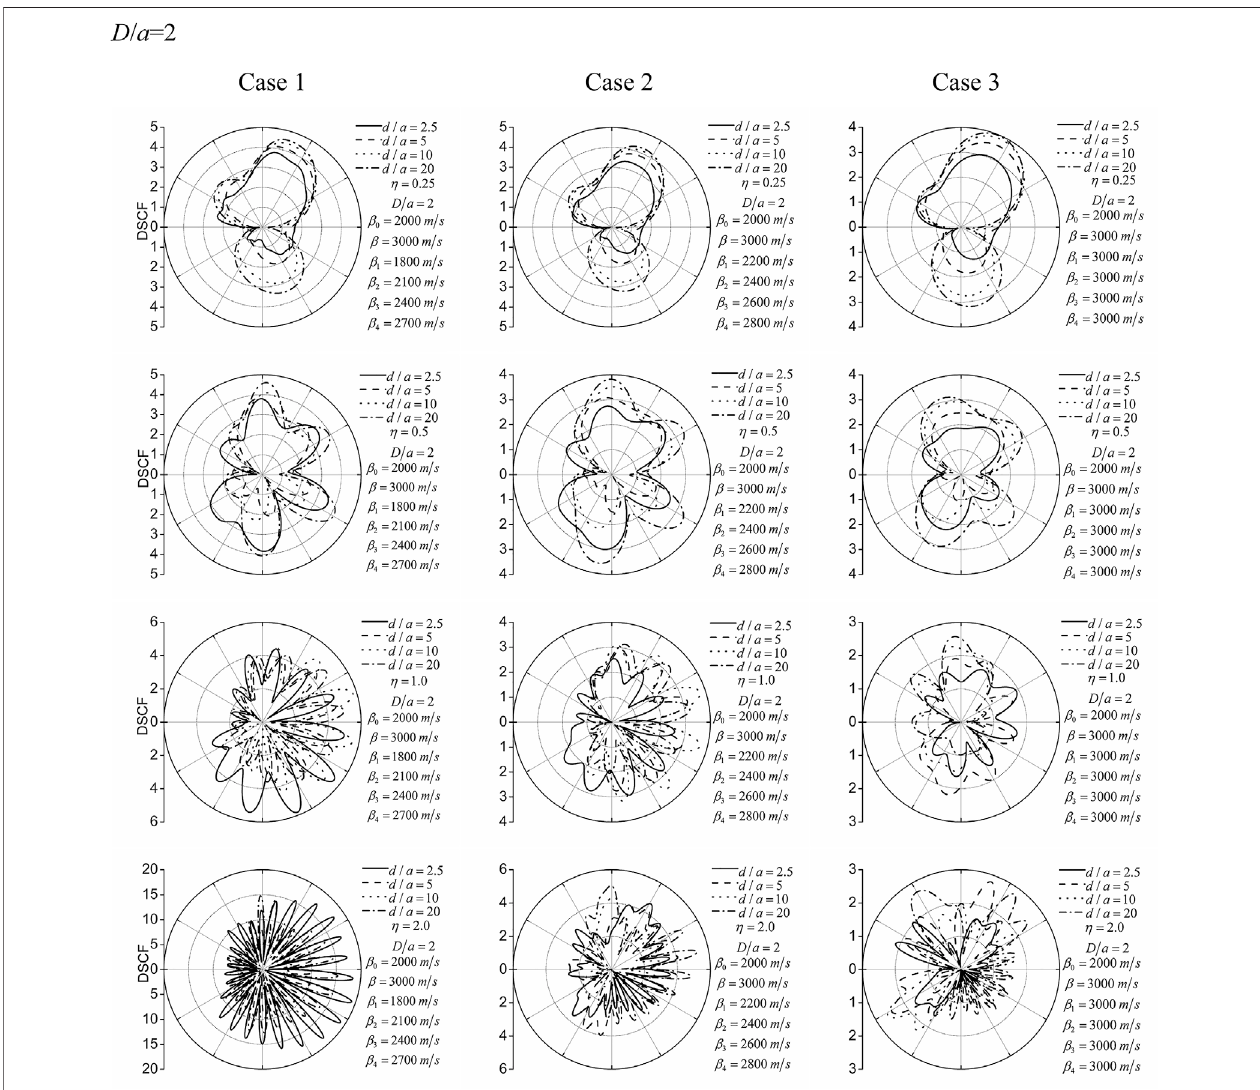
FIGURE 3 | DSCF of the lining outer surface for the lining burial depth D / a (cid:1) 2. Different lines (solid, dash, dot, and dash-dot lines), respectively, correspond to the wavesource – liningdistances d / a (cid:1) 2.5,5,10,and20.Rows1 – 4correspondtothedimensionlessfrequenciesoftheincidentcylindricalSH-wave η (cid:1) 0.25,0.5,1.0,and 2.0. Columns 1 – 3 correspond to the three